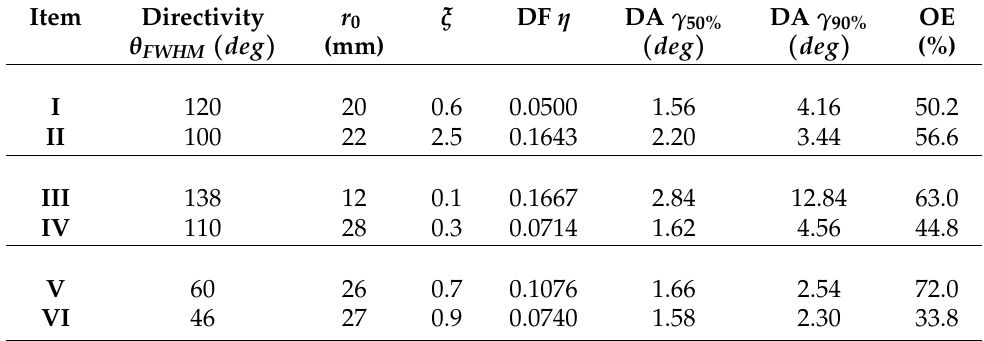
Table 2. Optimized parameters of collimating lenses for the six UV-LEDs and evaluated